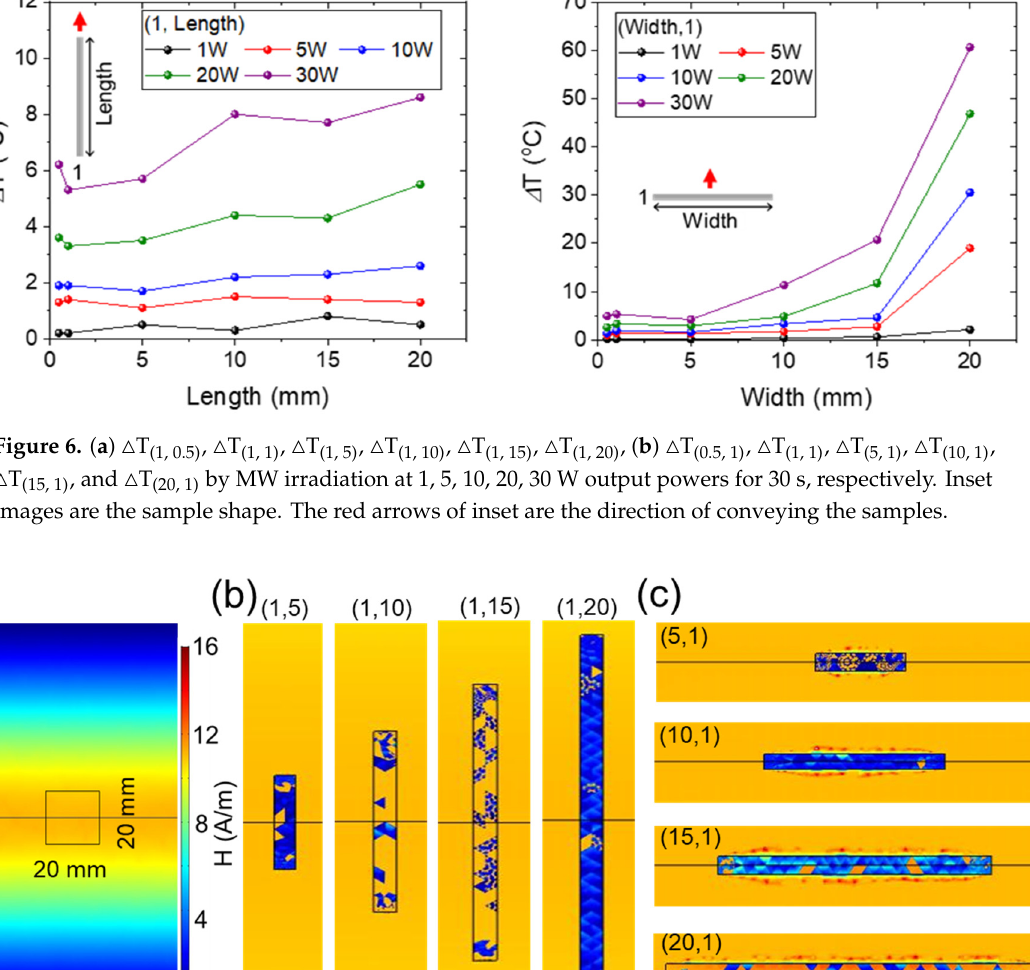
Figure 8. Simulation of resistive loss around bulk silver against the direction of conveying the samples in the TM 110 cavity: (width, length) = (5 mm, 1 mm), (10 mm, 1 mm), (15 mm, 1 mm), and (20 mm, 1 mm) bulk silver with 8 µm of thickness, respectively.